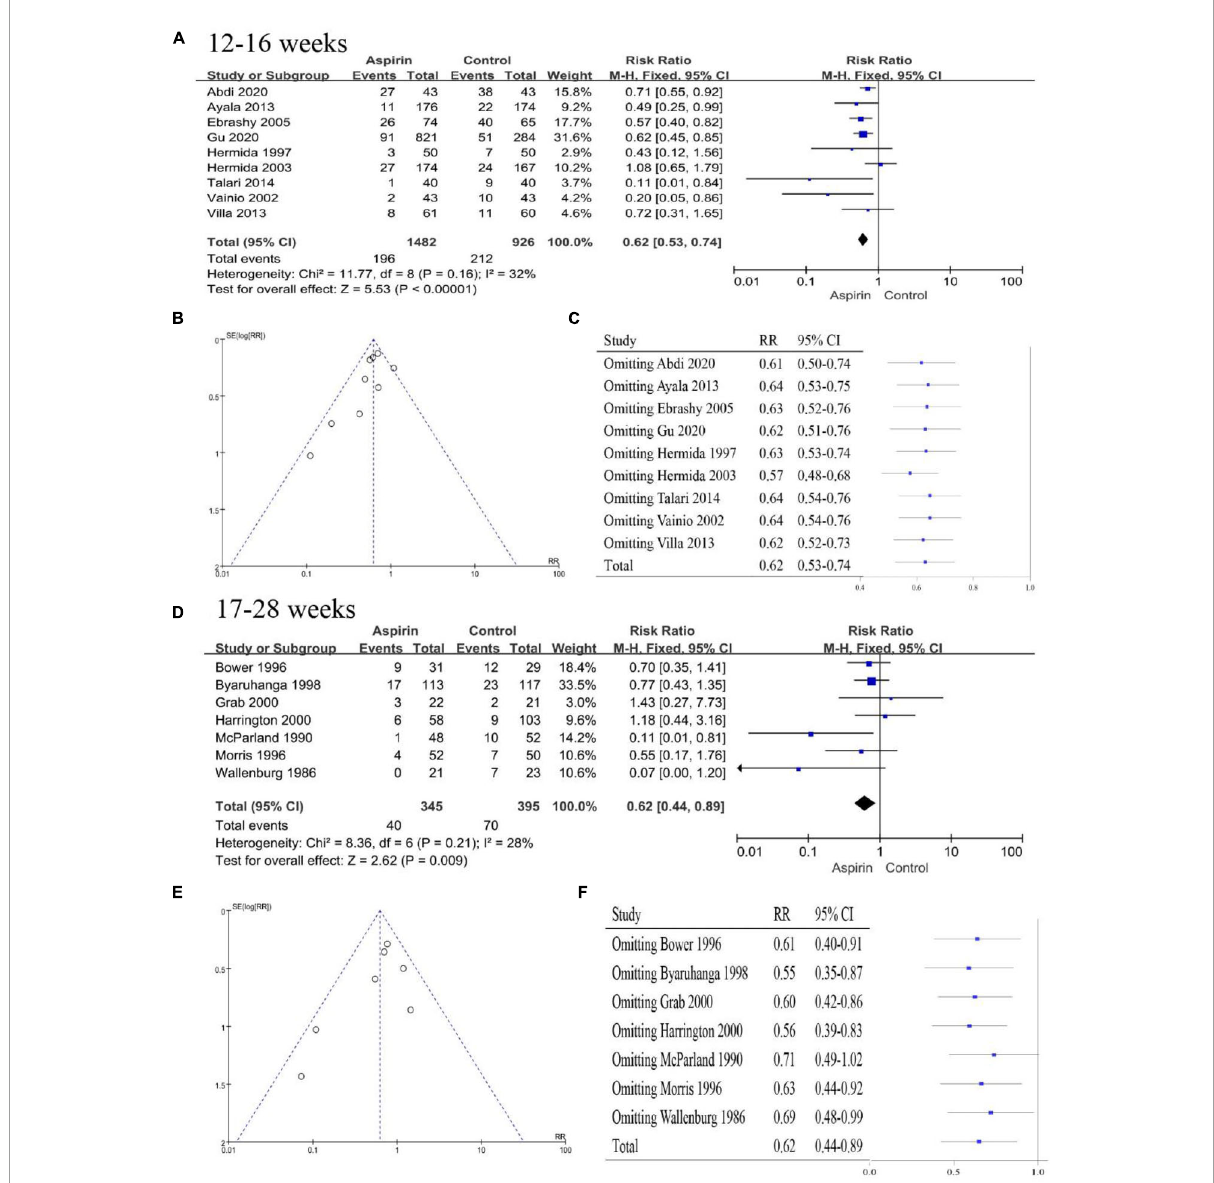
FIGURE6 Subgroup analysis by time of initial aspirin intervention. (A) Forest plot showing the intervention at 12–16 weeks. (B) Funnel plot showing the intervention at 12–16 weeks. (C) Sensitivity analysis of the intervention at 12–16 weeks. (D) Forest plot for the intervention at 17–28 weeks. (E) Funnel plot showing the intervention at 17–28 weeks. (F) Sensitivity analysis of the intervention at 17–28